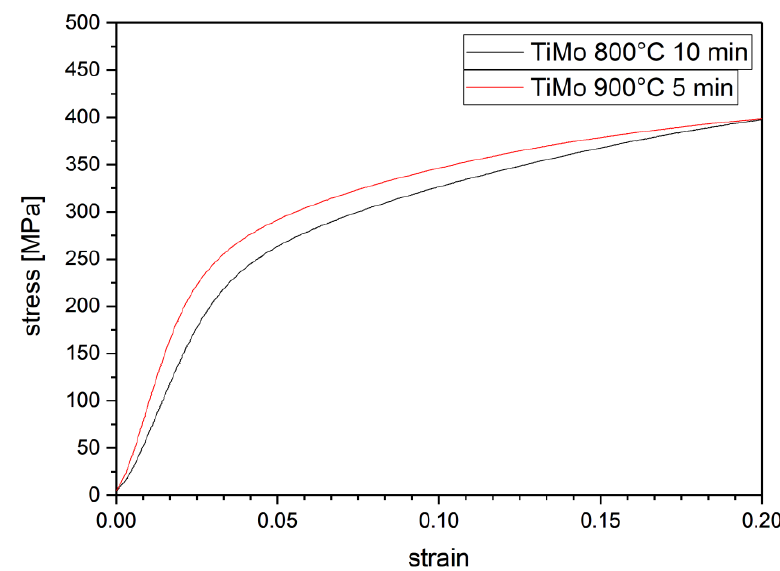
Figure 6. Mechanical behavior of the current open porous TiMo alloy. Representative compressive stress–strain curves of the porous TiMo alloy obtained by dealloying at 800 °C for 10 min and at 900 °C for 5 min. Table 2. Mechanical properties with standard deviation of the porous TiMo samples.